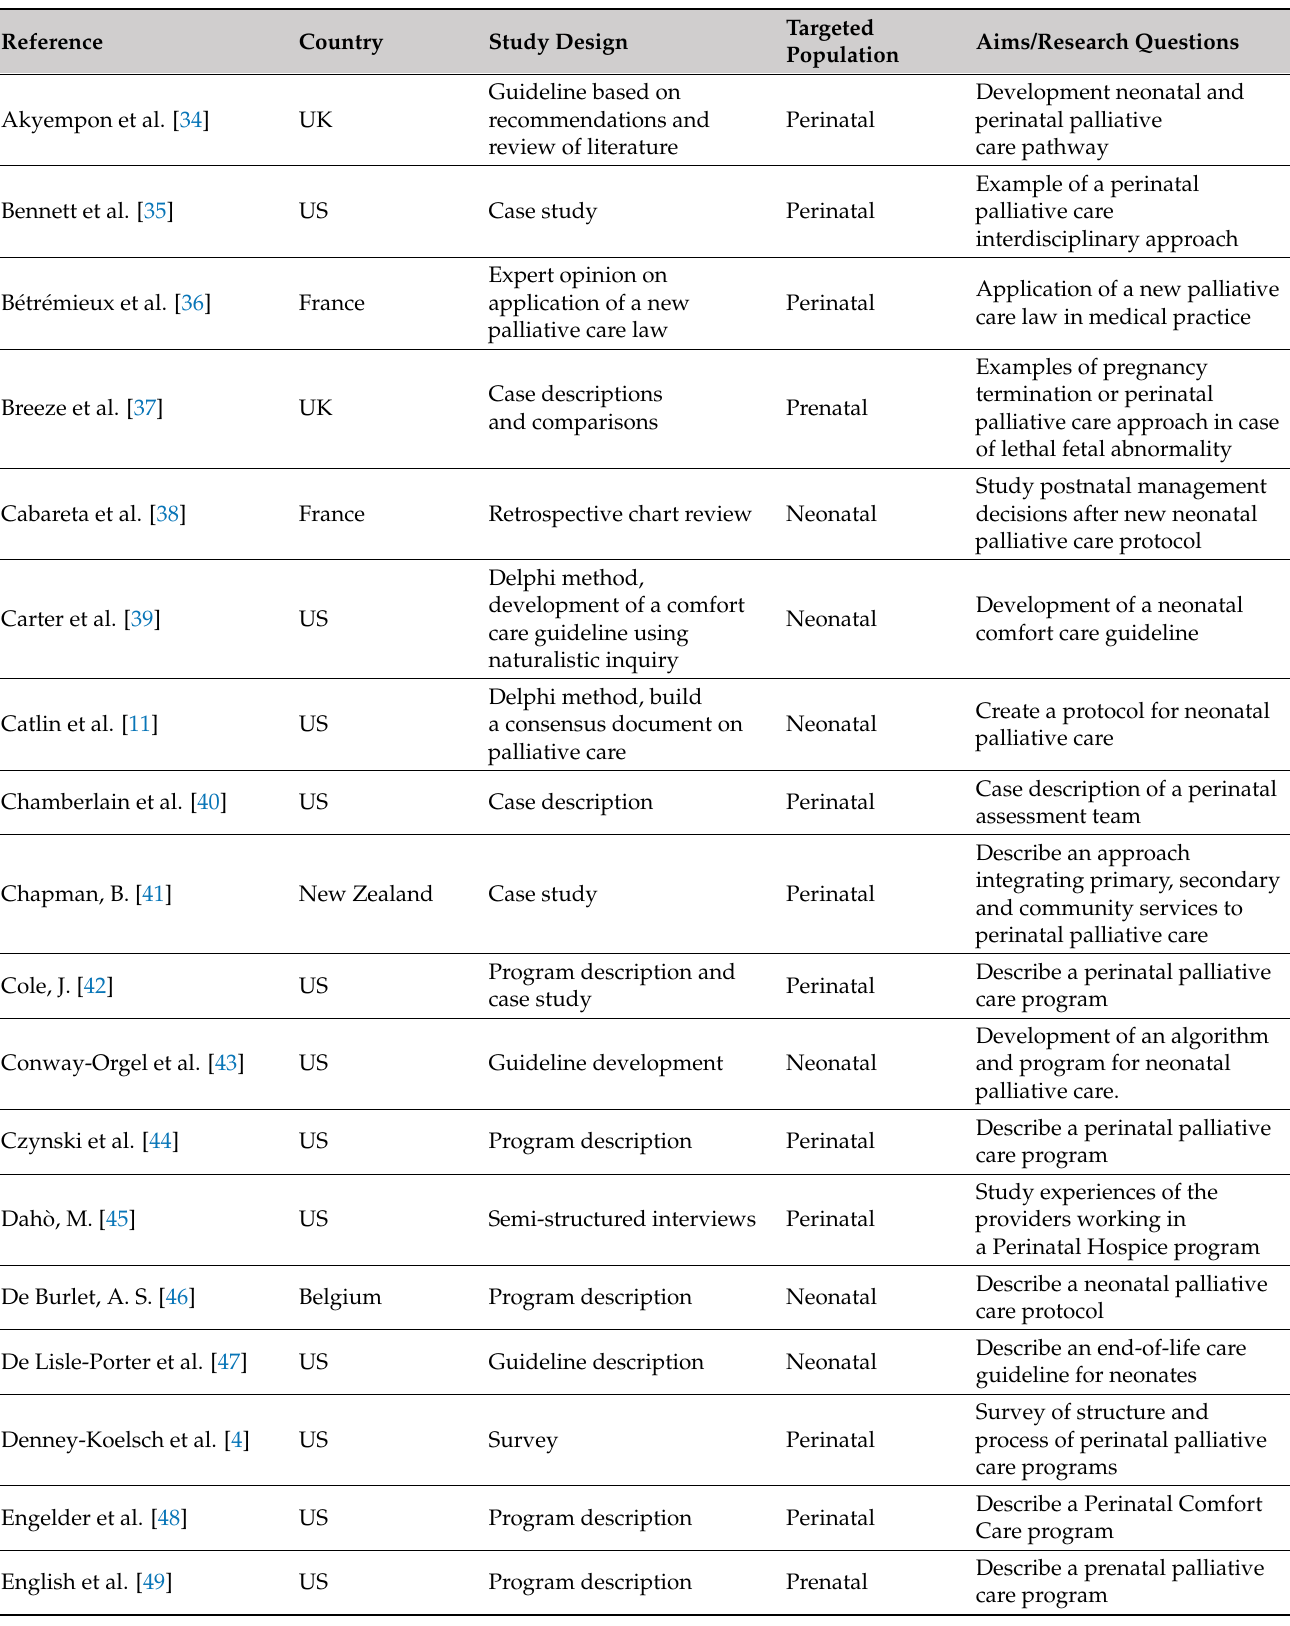
Table 4. Characteristics of additional included publications discussing a perinatal palliative care